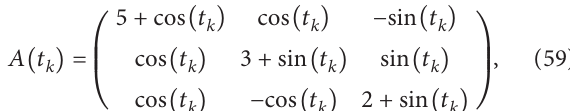
A − 1 k + 1 (i.e., k + 1 ) and by PGMDS10i algorithm (39) for example 1 (with ϵ and x . (b) Trajectories of y and x . (c) Trajectories of y 11 11 12 12